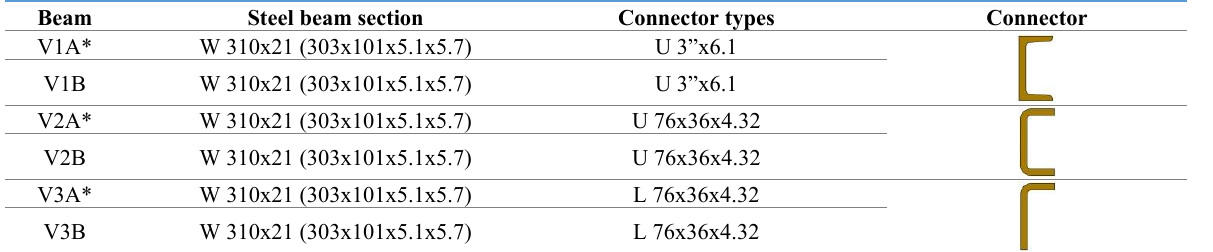
Table 1. Characterization of composite beam models